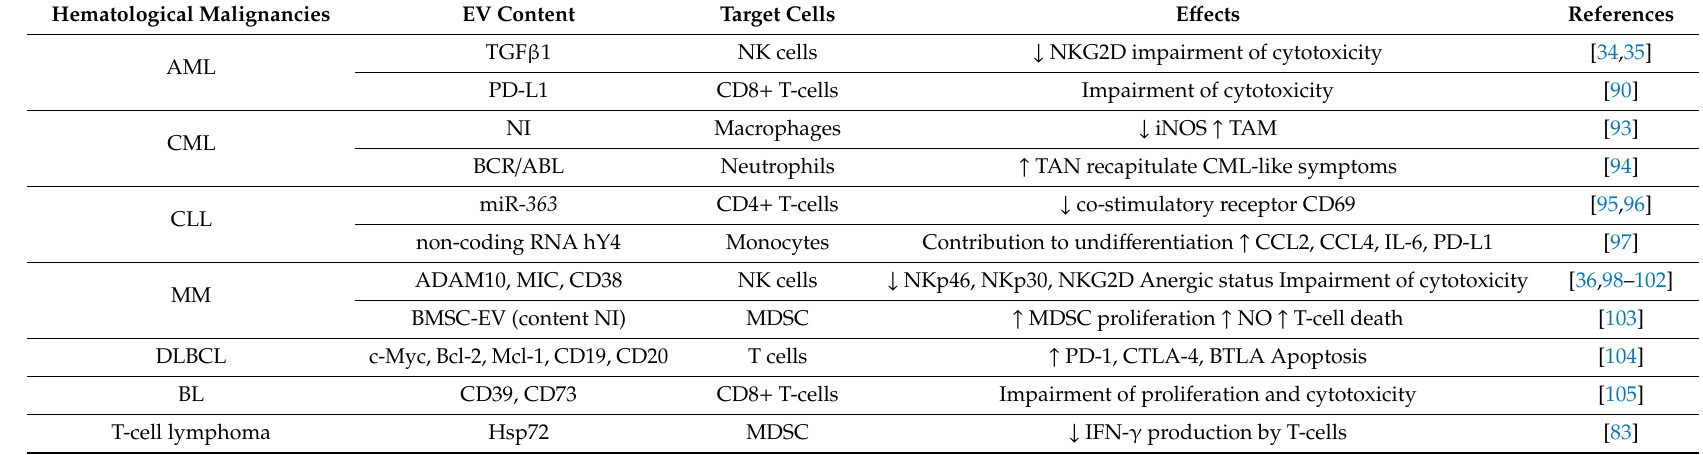
Table 2. Overview of the role of hematological malignancy-derived EVs on immune escape based on their content and type of target cell. Hematological